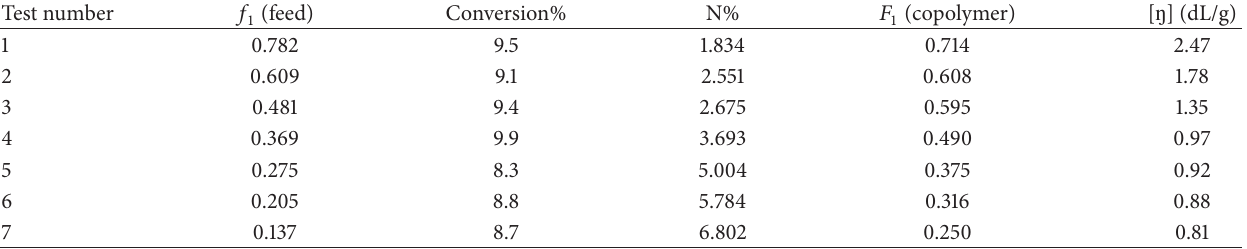
Table 1: Feed and copolymer compositions, conversion, and intrinsic viscosity [ p ] of TMEVS/NVP copolymer.